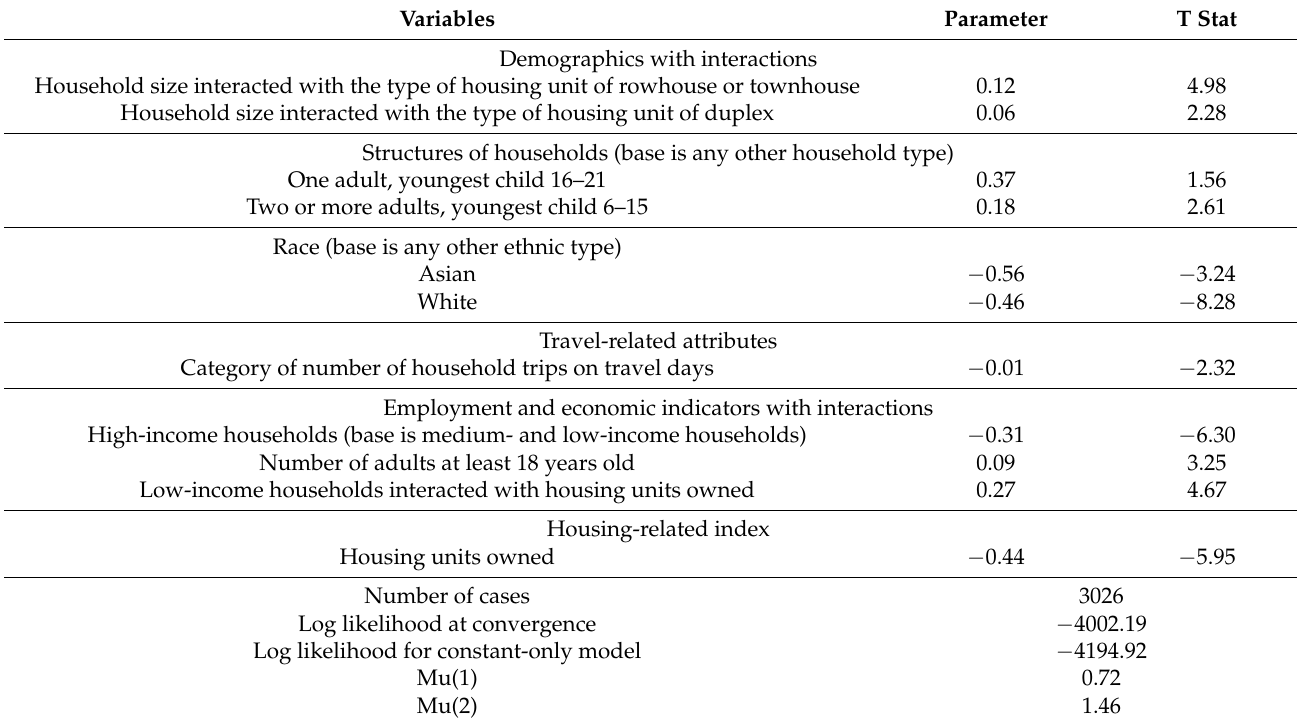
Table 7. Ordered response model of residential choice of housing density at census tract